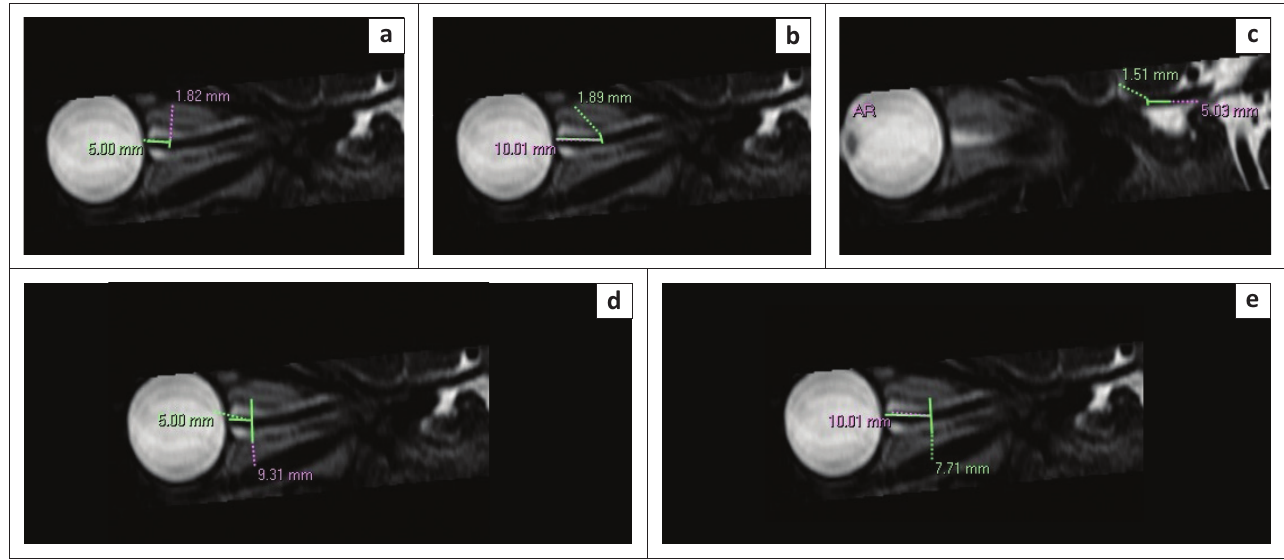
FIGURE 2: Reformatted sagittal T2W 3D magnetic resonance imaging of the right orbit demonstrating the measurement technique: (a and b) intraorbital optic nerve height 5 mm and 10 mm behind the globe, respectively; (c) intracranial optic nerve height and (d and e) optic nerve sheath height 5 mm and 10 mm behind the globe,